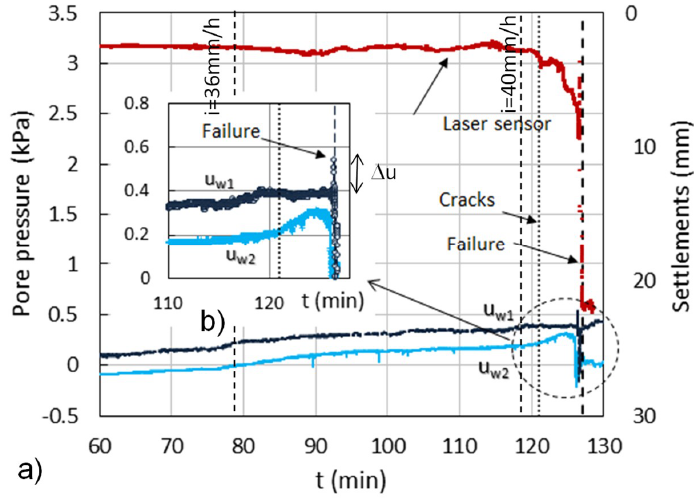
Figure 10. Pore pressures and settlements during test RP3 ( a ) and an enlargement of pore pressure measurements at failure ( b ).